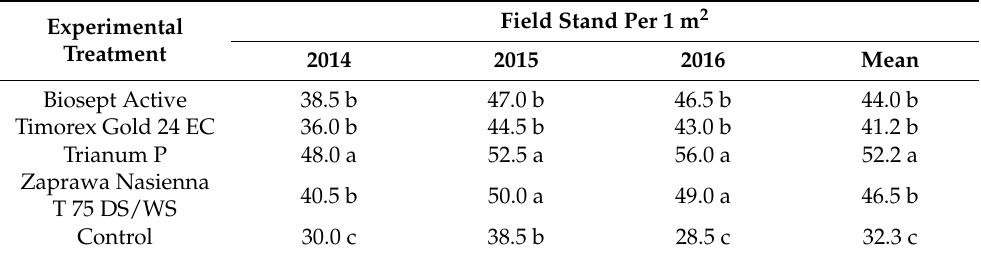
Table 1. Field stand of scorzonera seedlings.